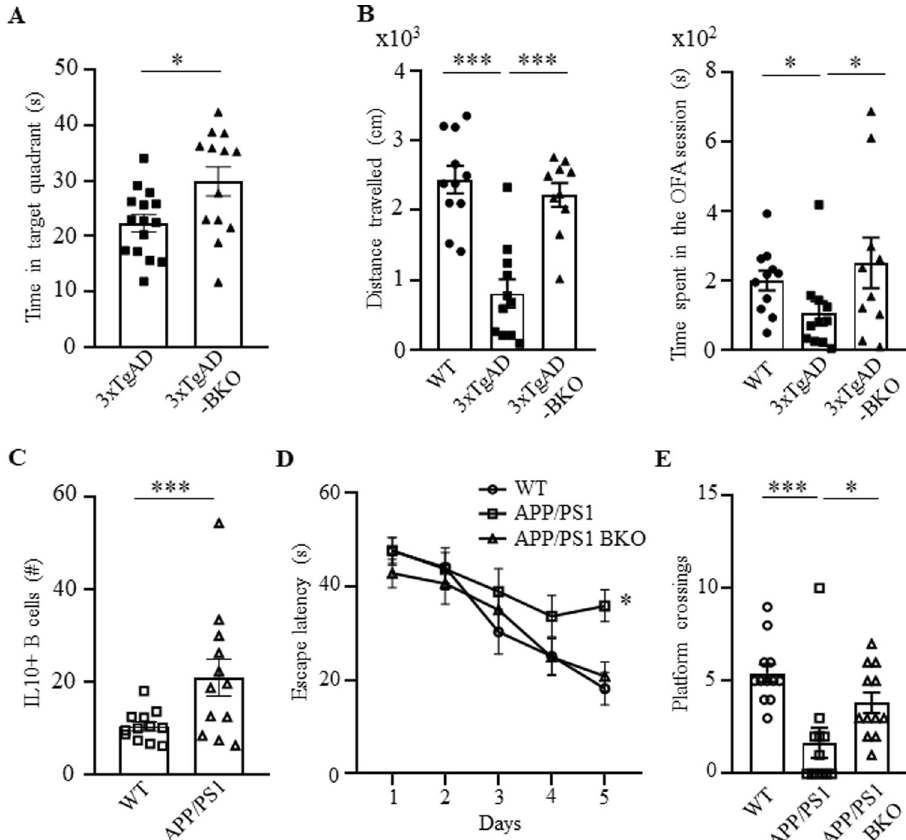
Fig. 2 Progression of AD required B cells. The impaired AD-associated cognitive ( A , the MWM test) and noncognitive locomotion activity ( B , total distance travelled, left panel, and time spent in center zone, right panel, in 30 min OFA test are shown) of 3×TgAD mice were improved in B-cell-de fi cient 3×TgAD-BKO mice ( n = 10 – 15 female). Compared with WT littermate, APP/PS1 mice upregulated numbers of IL10 + B cells in the peripheral blood ( C ). The impaired cognitive ability of APP/PS1 mice ( D , latency to reach the escape platform; E , platform crossing times in a probe test in MWM test) was reversed in APP/PS1-BKO mice. Mean± SEM is shown; each symbol is for a single mouse. A , B and D , E were independently reproduced three and two times, respectively. Gating strategy is shown in Supplementary Fig. 9A. * p < 0.05; *** p < 0.001 in unpaired t test ( A ), Mann – Whitney test ( C ), one-way ANOVA ( B , left), Kruskal – Wallis test ( B , right and E ) or two-way ANOVA ( D